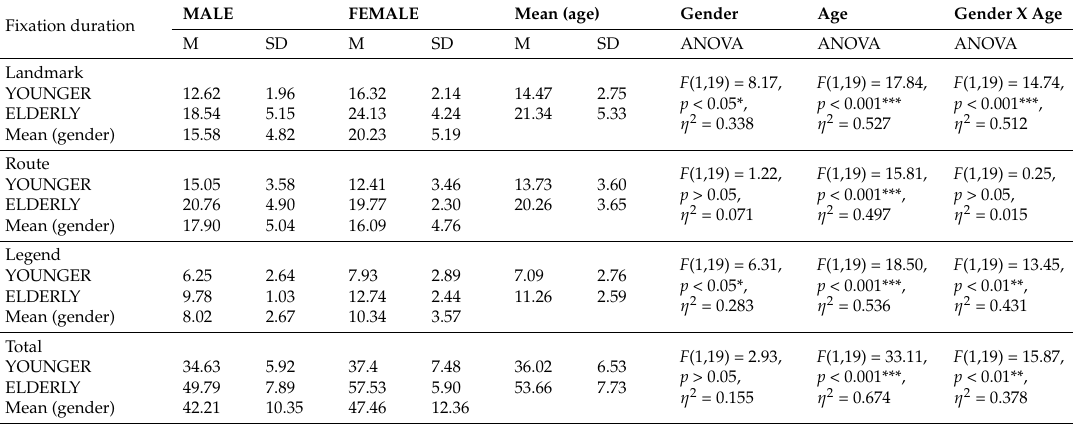
Figure 9. Results of visual attention on different types of AOIs in Task 2. Table 5. Descriptive and inferential statistics for Task 2 (Route memorization).